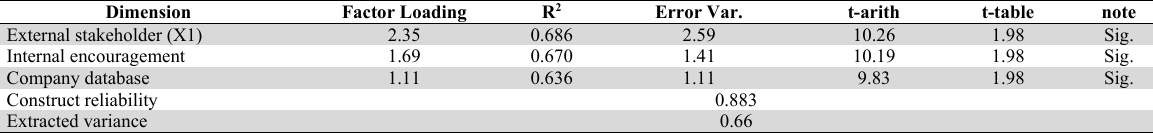
Analysis of the Measurement Model for SME Strategic